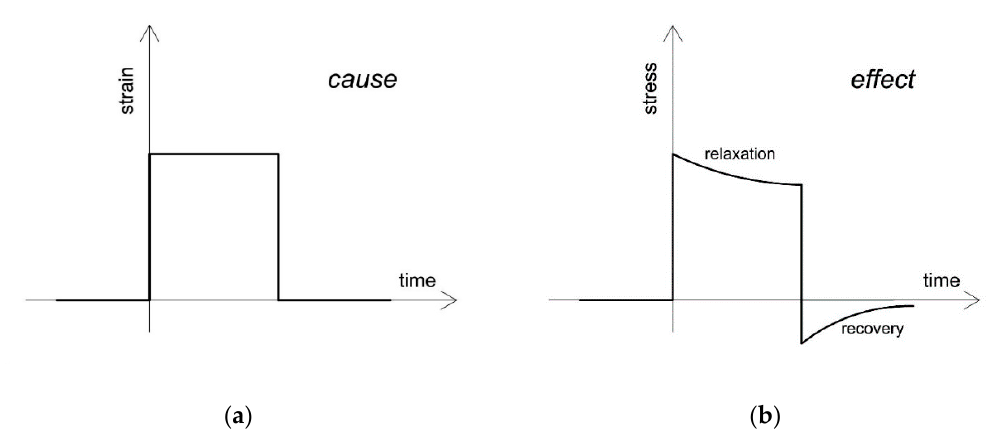
Figure 1. Relaxation and recovery. ( a ) The history of applying and removing strain over time (cause). ( b ) The stress response following the application and removal of strain as a step function of time